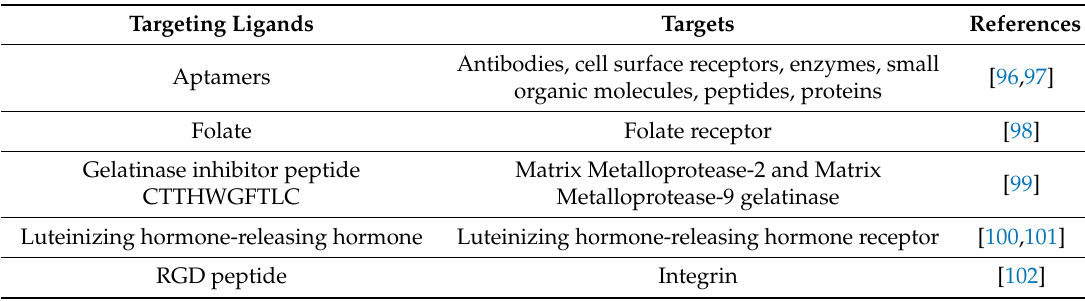
Table 3. Example of some ligands used in active drug targeting adapted from